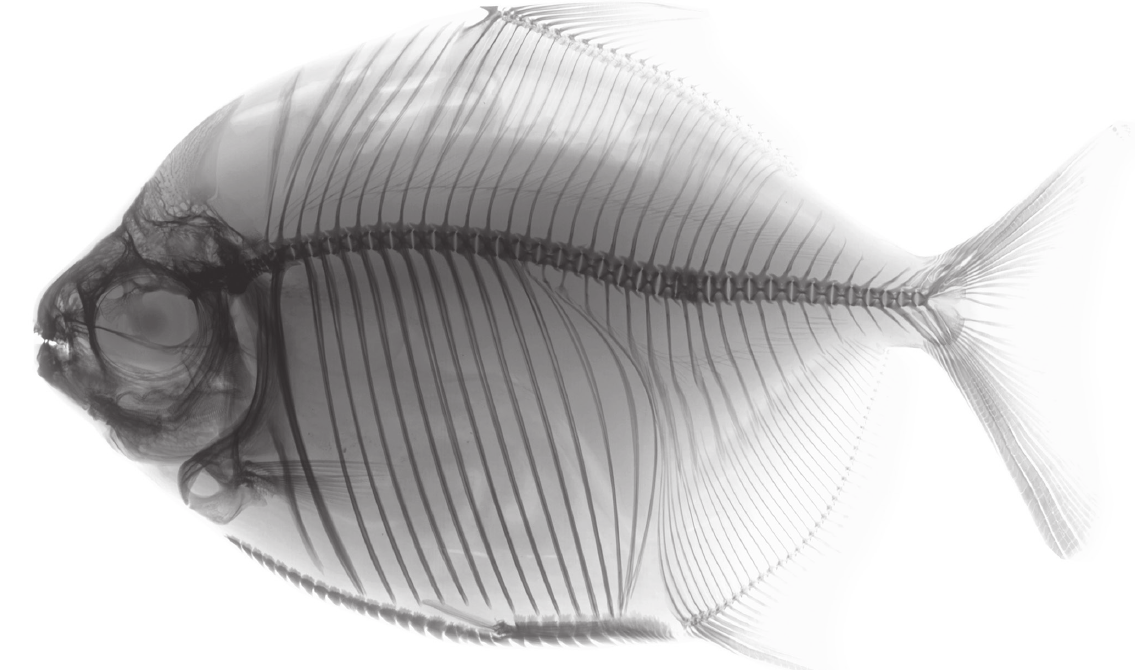
Fig. 2. Radiograph of Myloplus taphorni , paratype, UMMZ 251911, male, 154.9 mm SL. Courtesy E. Holm